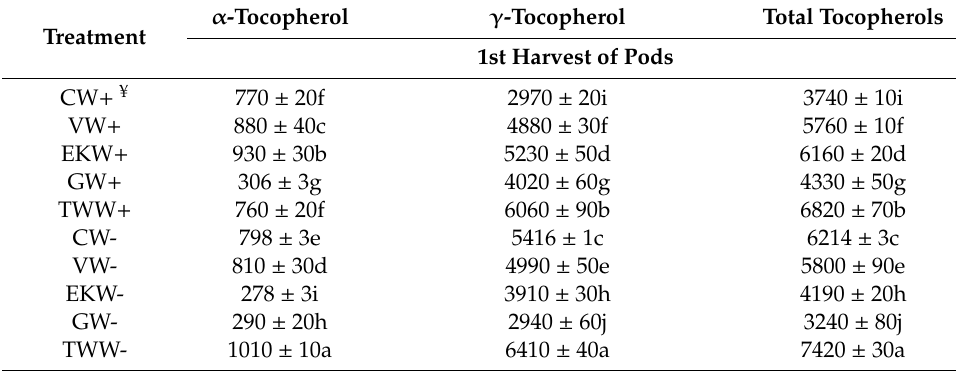
Table 5. Composition in tocopherols of the studied pods ( µ g / kg dw) and seeds (mg / kg dw) of beans in relation to the irrigation regime (mean ±